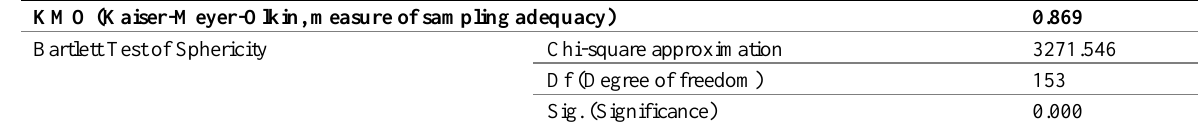
Table 4: Test of